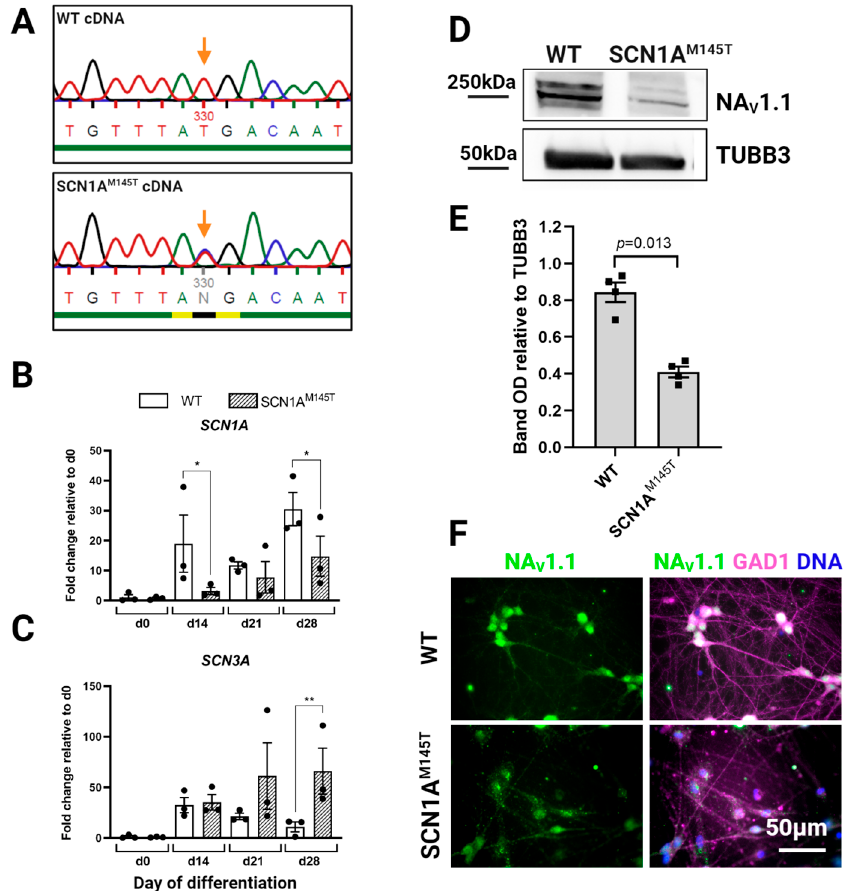
Figure 4. Expression of SCN1A gene and Na V 1.1 protein in idNs. ( A ) Sequencing of cDNA obtained by reverse transcription of SCN1A mRNA from WT- and SCN1A M145T -idNs. In the SCN1A M145T cells, the double peak in the mutation site (indicated by the orange arrow) demonstrates that both alleles (one with the original nucleotide T and the other with the mutated one C) were transcribed. ( B ) qRT-PCR analysis of SCN1A gene in idNs at day of differentiation 0 (NSCs), d14, d21 and d28. SCN1A M145T cells showed a lower expression of SCN1A during differentiation compared to WT, although in both cell lines the expression increases following idNs maturation. ( C ) The expression of the embryonic isoform of sodium channel SCN3A increases with the progress of cell maturation in SCN1A M145T idNs, while it decreases in WT idNs as the cells become more differentiated. For both graphs, GAPDH was used as a housekeeping gene; data are mean ± SEM of three